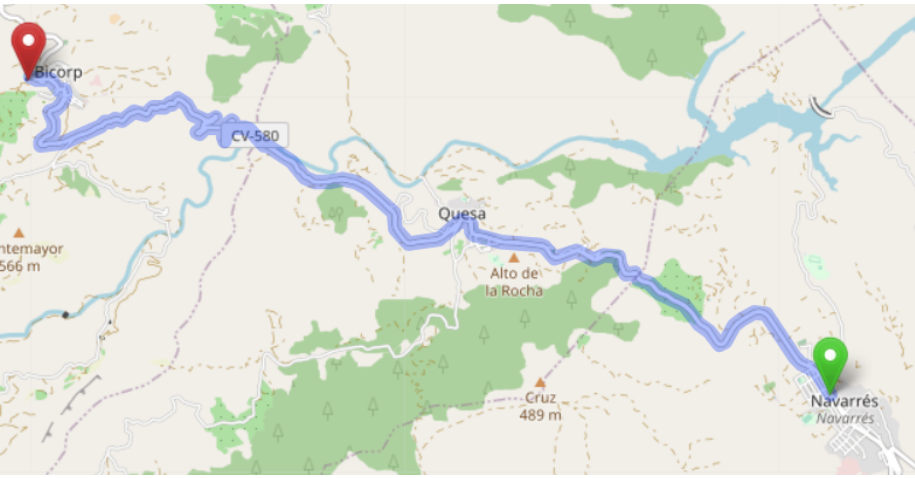
Figure 2. Shortest path between Navarrés and